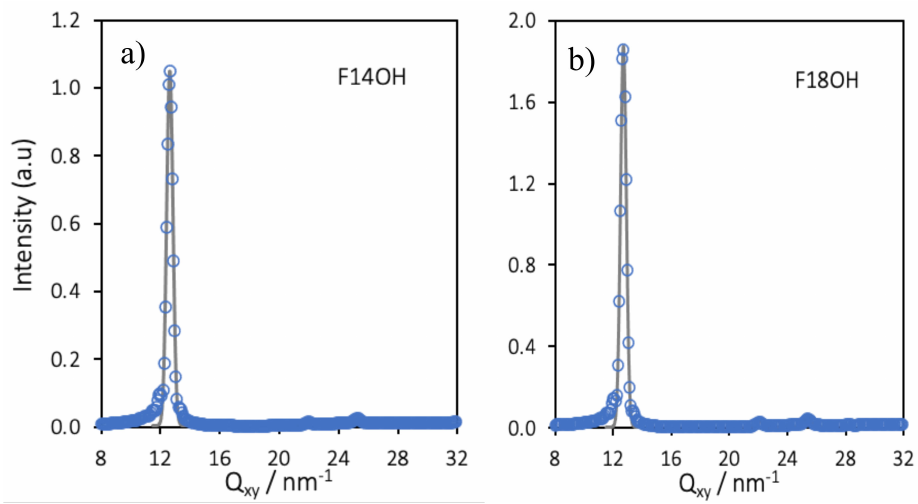
Figure 8. Simulated in-plane (Q xy ) GIXD spectra of the 550 molecules Langmuir films of F14OH ( a ) and F18OH ( b ) at a molecular area of A = 0.6 nm 2 / molecule. Data points represent the calculated spectra and lines the Gaussian fits of the